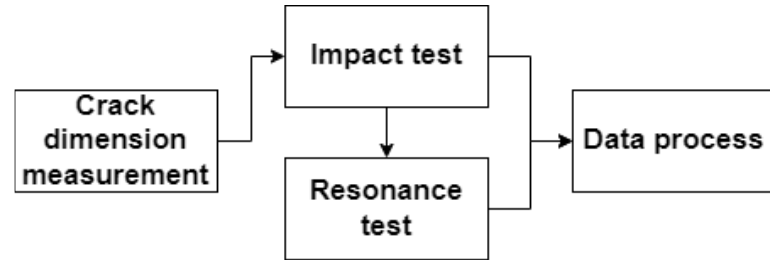
Figure 4. Experimental procedures.